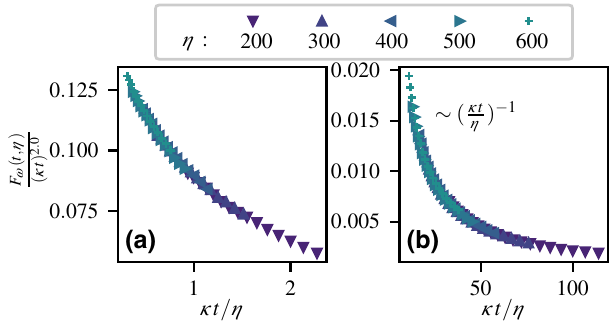
FIG. 4. Finite-size scaling of the FI F ω ( t , η) [cf. Eq. (21)] for the photon-counting signals of the critical open Rabi model ( g = g CP ), in both (a) the transient regime κ t (cid:2) η and (b) the long-time regime κ t (cid:10) η . Parameters: κ = 0.1, ω = 1. Each data point represents an average of 10 5 independent trajectories in (a), and 10 4 independent trajectories in (b). The sampling